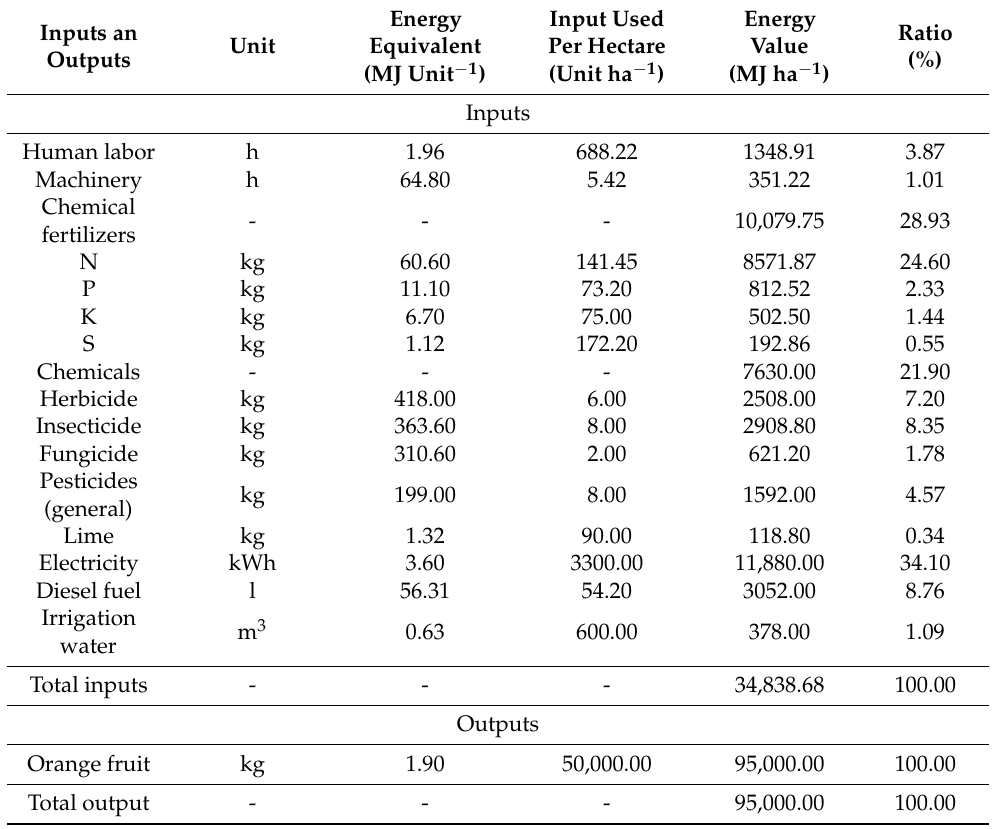
Table 3. Energy balance in the production of orange